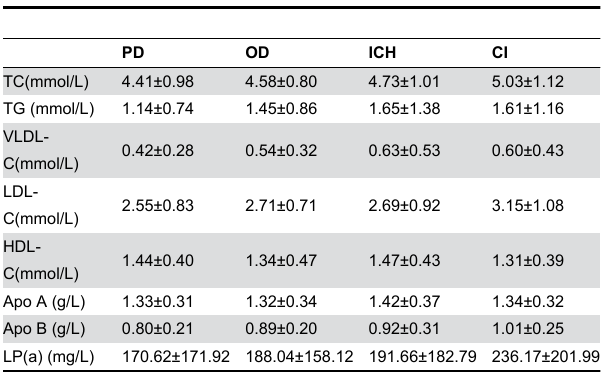
Table 2. The serum levels of lipids and lipoproteins in the four groups.